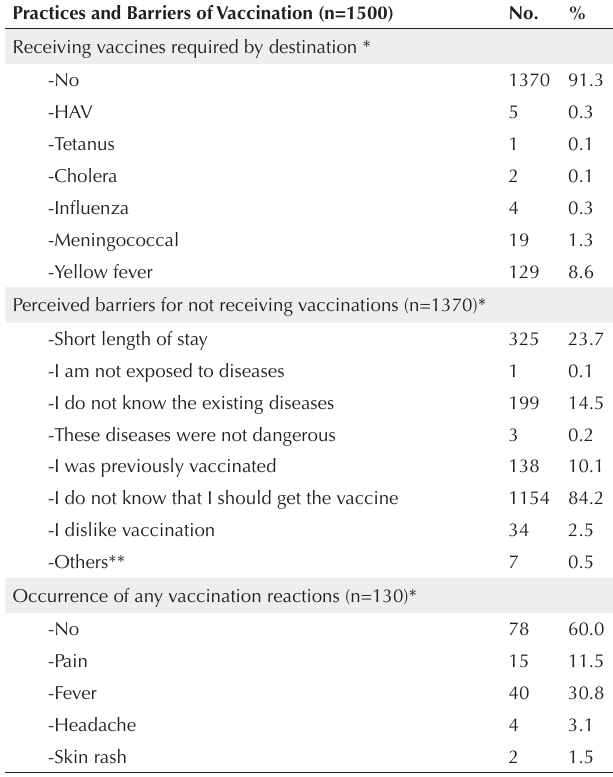
Table 3. Distribution of Travelers at Cairo International Airport According to Practices and Barriers of Vaccination Practices and Barriers of Vaccination